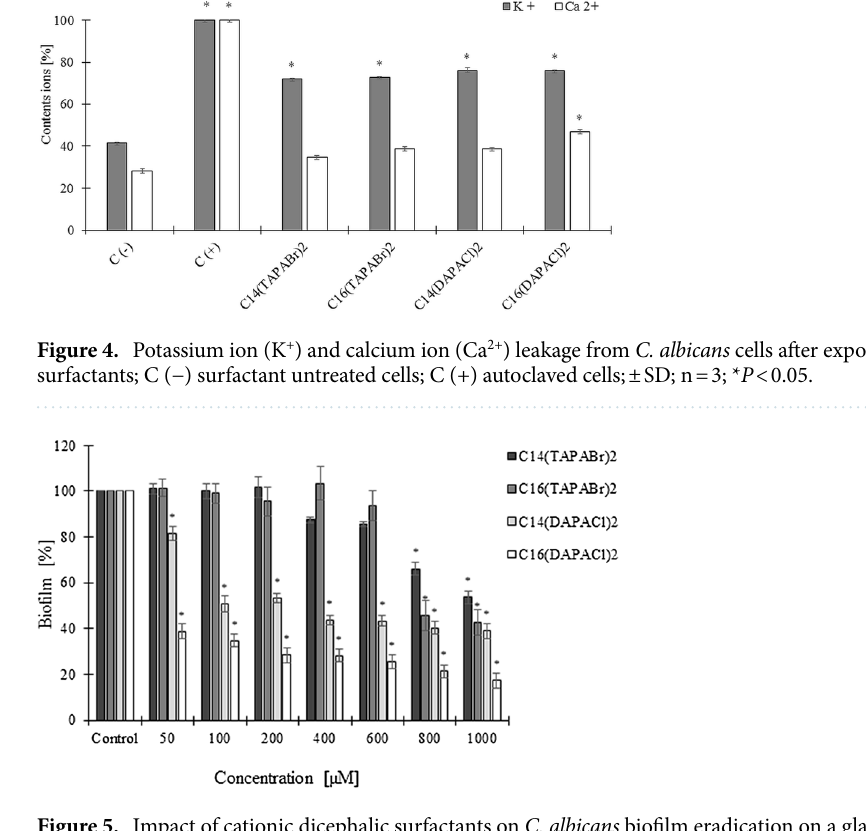
Figure 5. Impact of cationic dicephalic surfactants on C. albicans biofilm eradication on a glass surface; mean ± SD, n = 3; *significantly different from the control P <